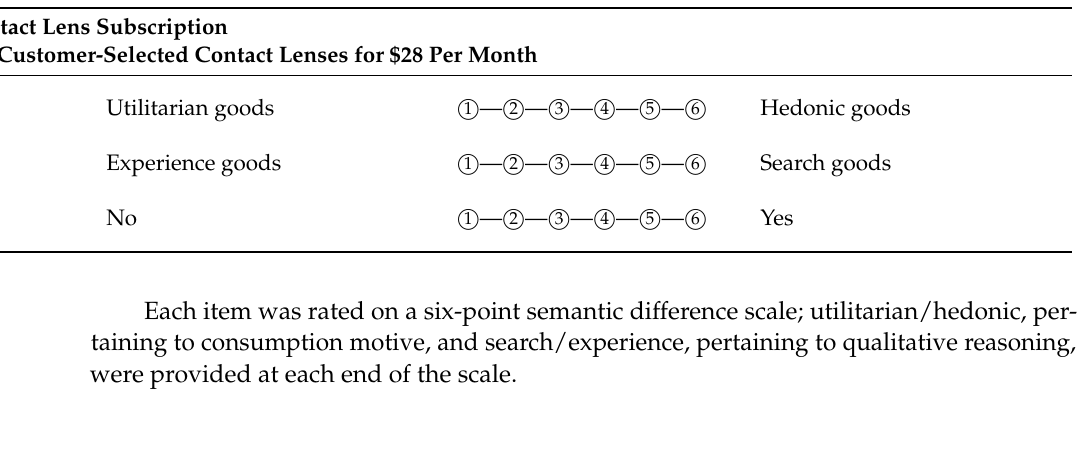
Table 3. Example of survey items (after introduction of the subscription